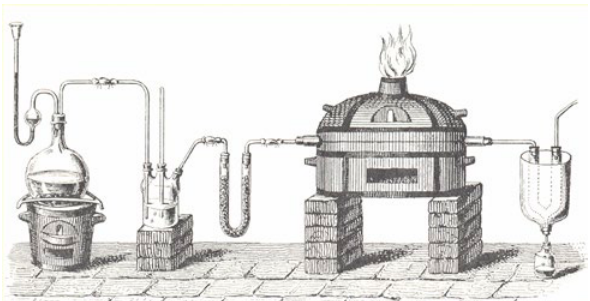
Figure 4. The first step in Ørsted’s isolation of aluminium, the syn- thesis of AlCl 3 . In modern nomenclature the process is Al 2 O 3 +3C +3Cl 2 →3CO+2AlCl 3 . Reproduced from a Danish textbook of 1853 (H. Westergård, Uorganisk Kemi